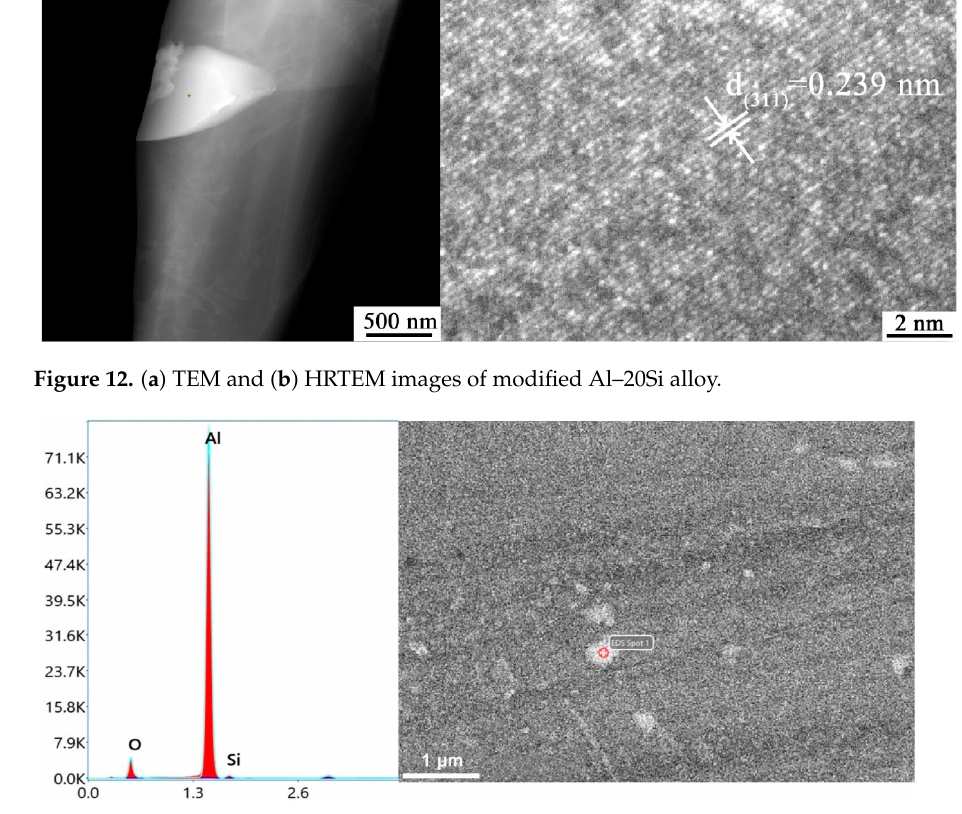
Figure 13. EDS spectra of modi fi ed Al–20Si alloy.